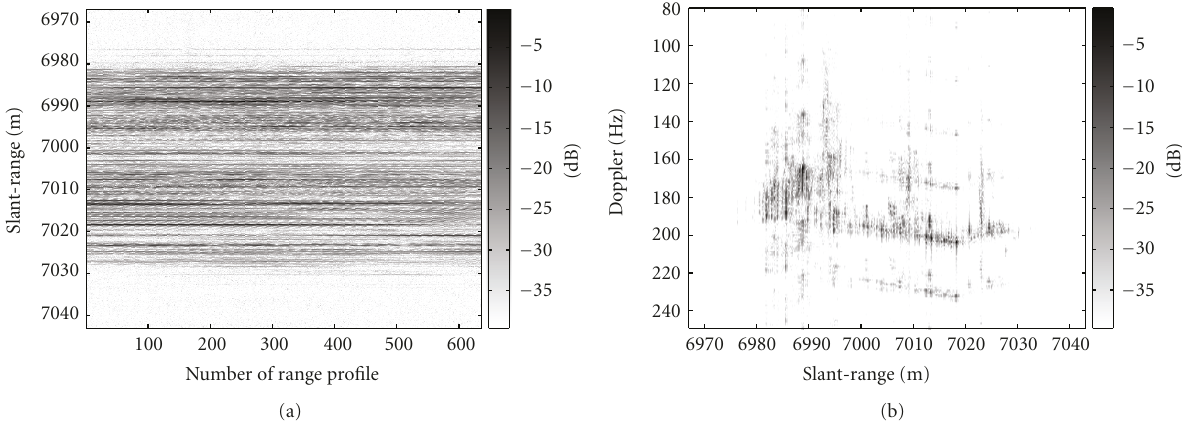
Figure 22: (a) Range profiles and (b) ISAR image for the real data of the vessel after using the minimum entropy-based approach.